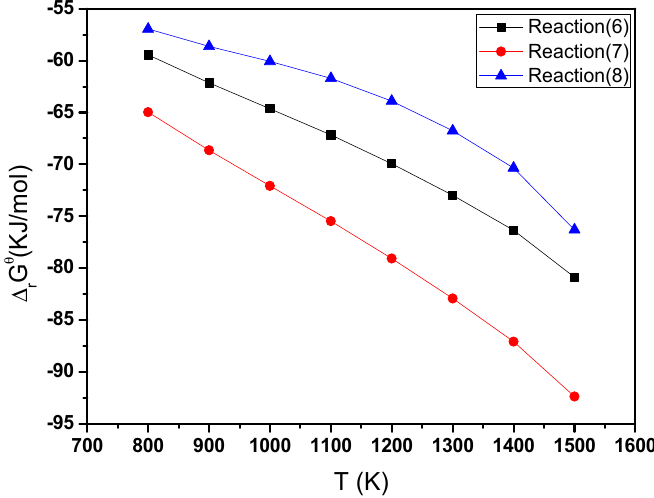
Figure 11. The Gibbs free energy and temperature variation curves of the reaction type (6) to reaction type (8) over the range 800 K to 1500 K (527 °C to 1227